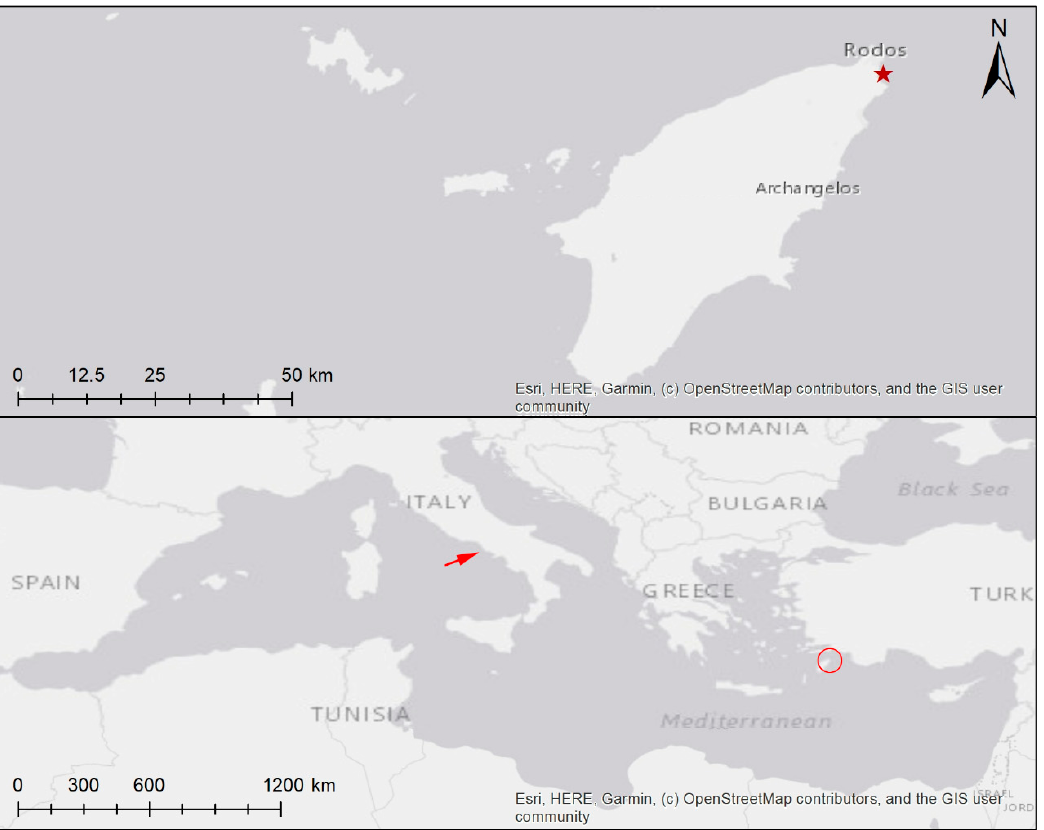
Figure 1. Geographical position of sites. Above: Rhodes Island with asterisk at sampling site. Below: Rhodes (circle) within the Mediterranean. Arrow points to Ischia where the previous isolate of Schizocladia was found in 1987.